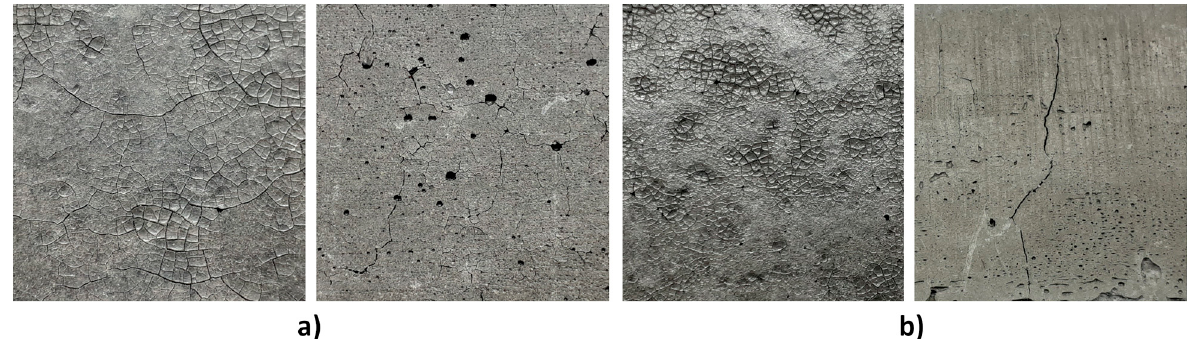
Figure 3. Cracked surface of samples after 28 days ( a ) upper and side (left-right) surface of the sample made of mixture FBC FA + CRT; ( b ) upper and side (left-right) surface of the sample made of mixture FBC FA.